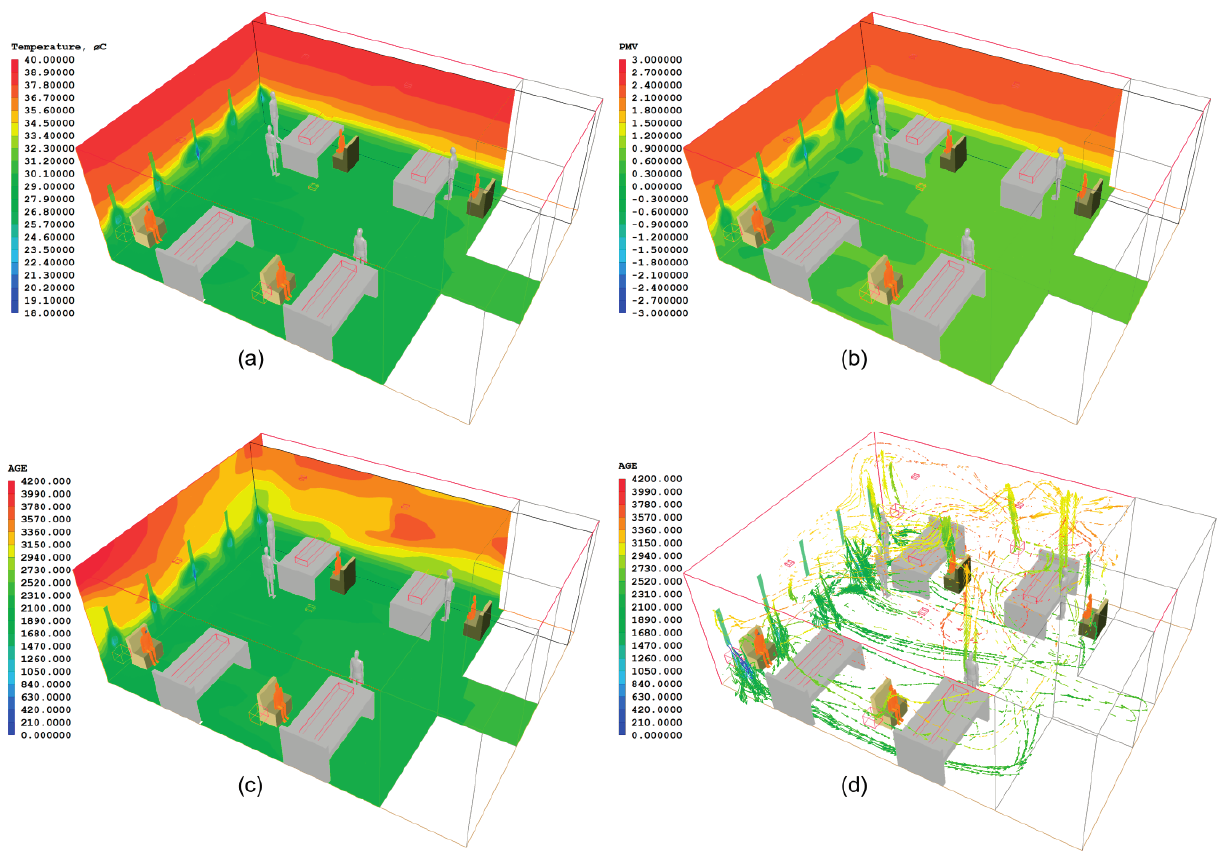
Figure 4. Airflow characteristics of the base case design showing contours of: ( a ) Temperature; ( b ) PMV; ( c ) Age of air; and ( d ) Streamlines of displaced air particles as they flood the